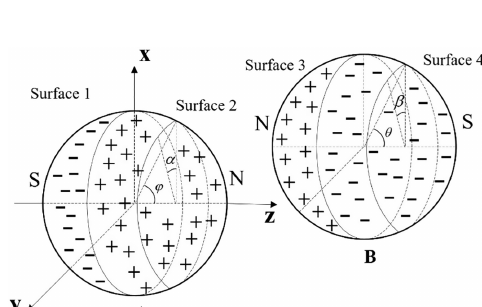
Figure 12. Schematic diagram of geometric dimensions and interval between two cylindrical magnets